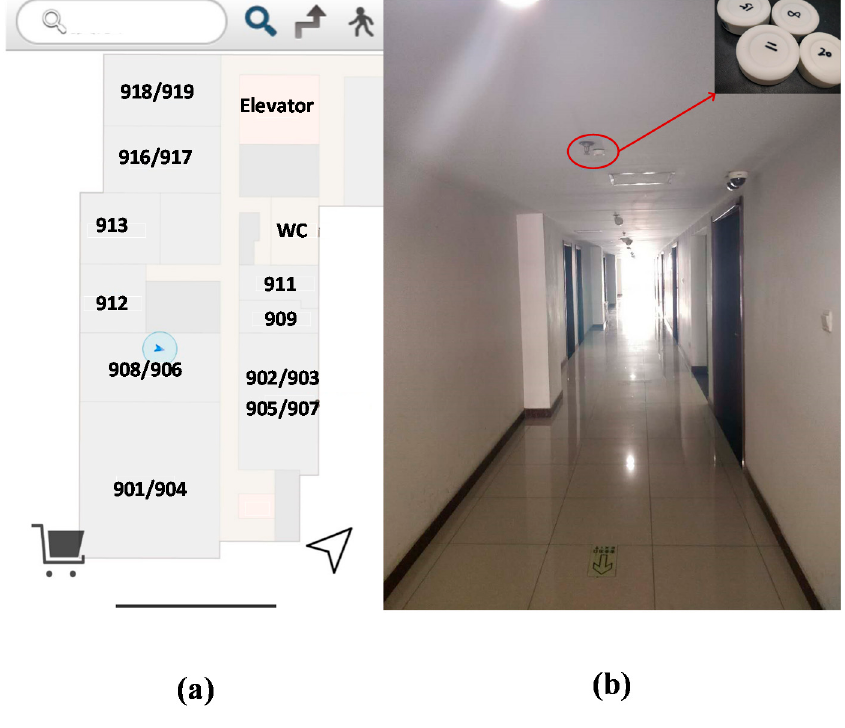
Figure 8. ( a ) The developed Android app; ( b ) Test environment with deployed BLE beacons.